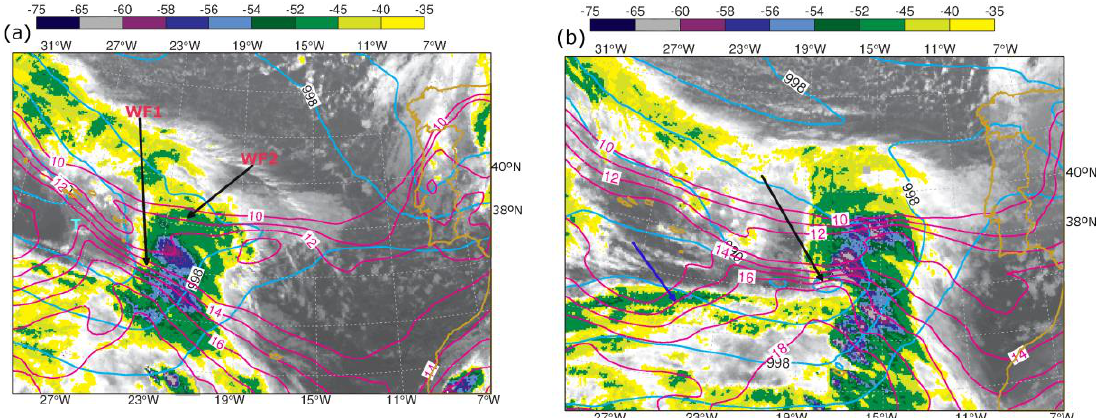
Figure 3. IR10.8 brightness temperature (shaded from −35 to −75 °C) superimposed with MSLP (4 hPa intervals, cyan lines) and wet-bulb potential temperature at 925 hPa (1 °C intervals, from 10 to 18 °C in magenta lines). ( a ) At 12:00 UTC and ( b ) 18:00 UTC on 22 December 2009. The triple point is marked with a T and the warm fronts, WF1 and WF2, are also marked in ( a ). The incipient surface low is indicated by the black arrow and the blue arrow points to a cold front in ( b ).